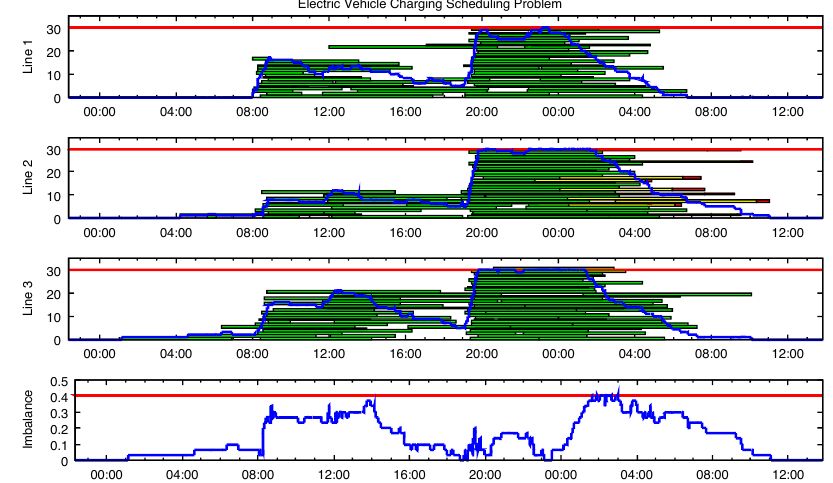
Figure 3. Example of a feasible schedule of a Type 1 instance of scenario 1, with n = 30 and ∆ = 0.4, showing in green the charging intervals of the EVs without tardiness, and in yellow and red the EVs that complete charging after their due dates. The red portion indicates the interval after the corresponding due date. Blue plots in each of the three lines show the load level N i ( t ) , which is always lower than or equal to n = 30. The bottom graph shows the imbalance at each time point in the three lines, which is always lower than or equal to ∆ =